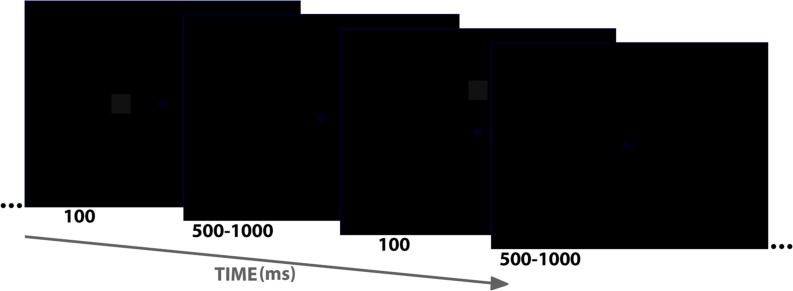
Schematic representation of the stimulus sequence showing duration of stimuli and inter-trial interval as well as two of the five stimuli used (< or left to fixation and ∧ or above fixation). Please note that both blue diamond (fixation) and gray square are very dark.